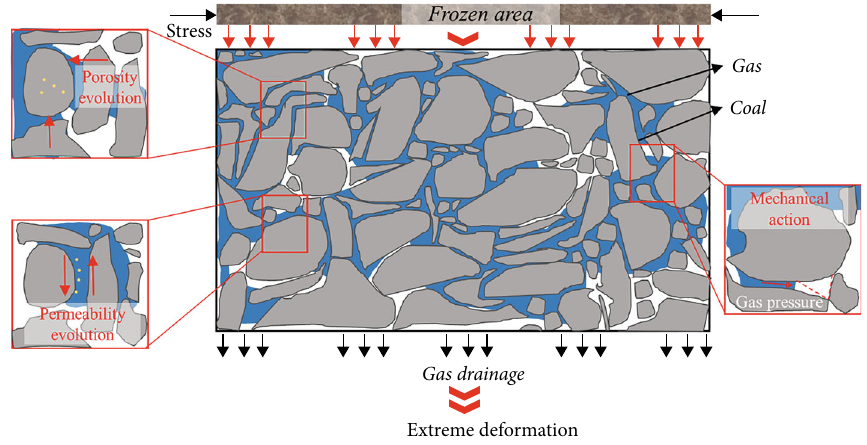
Figure 1: Schematic diagram of the coupling